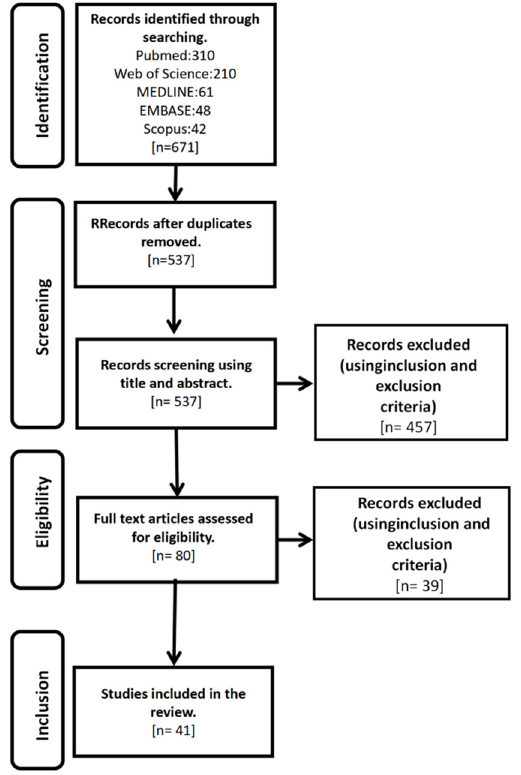
Figure 1. Flowchart detailing the systematic search, screening, eligibility, and inclusion procedure.